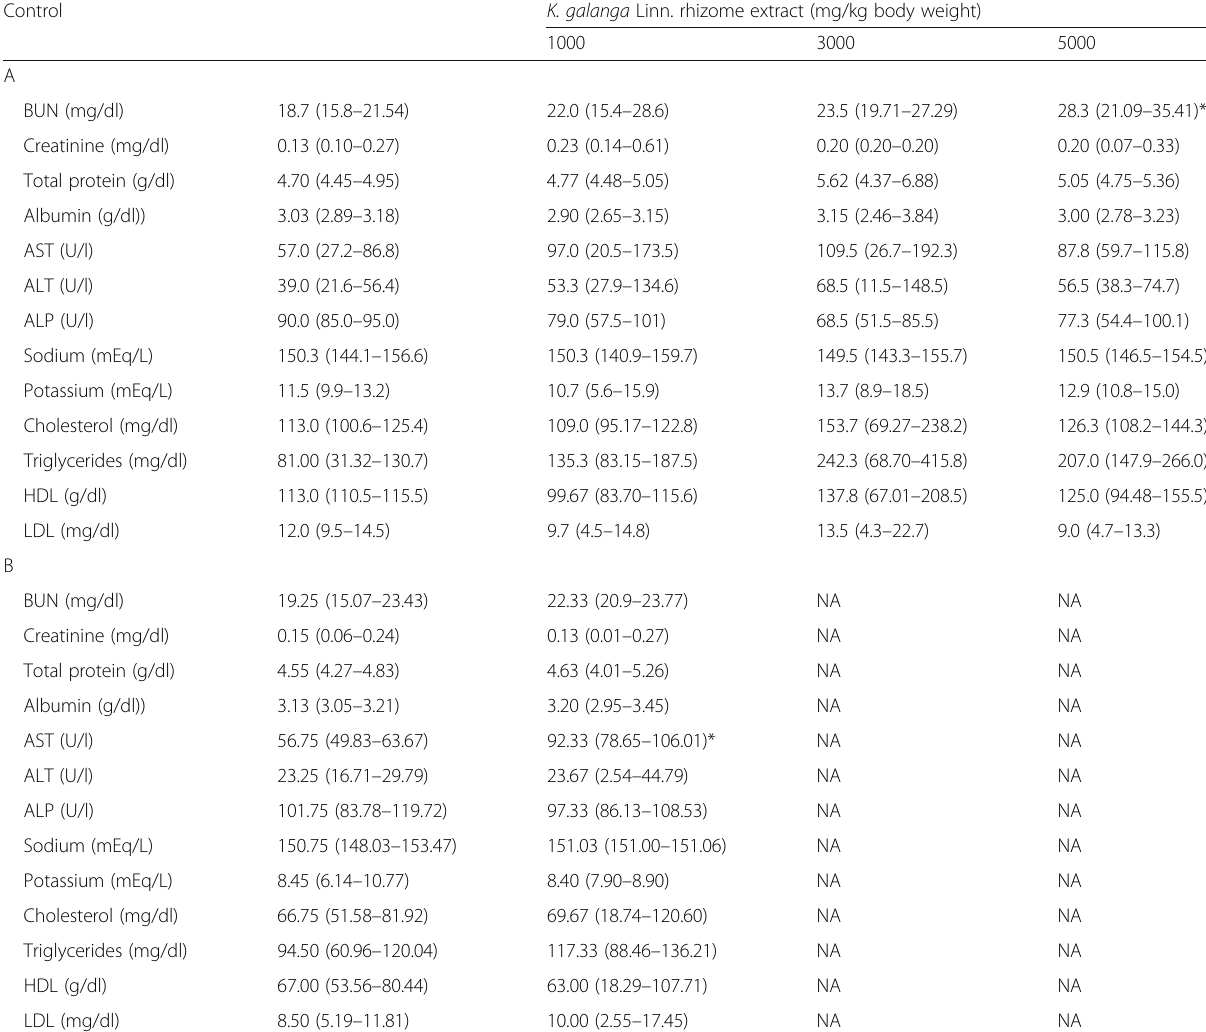
Table 2 Serum biochemistry profiles of (A) male and (B) female mice at the end of subacute toxicity dosing of K. galanga Linn. rhizome extract (1000, 3000, and 5000 mg/kg body weight) and untreated control mice. Data are presented as median (95%